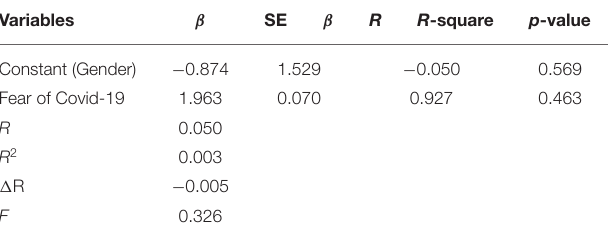
TABLE 8 | Summary of multiple regression analysis between gender, fear of COVID-19, and emotional distress ( N = 500). Variables